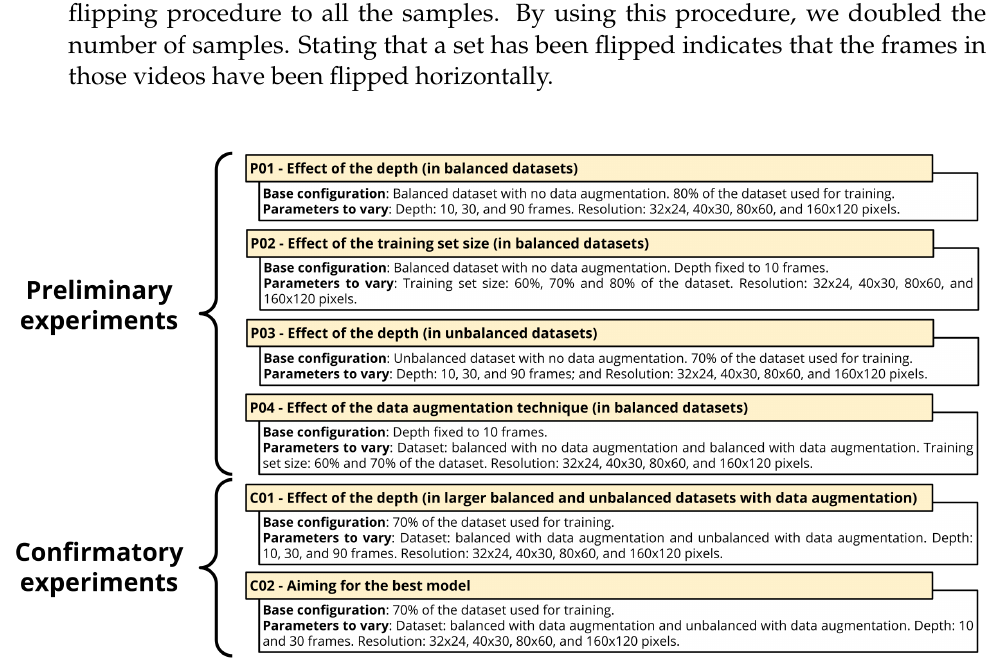
Figure 5. Overview of the experimental setup followed in this work. For a detailed description of the parameters and the relation of the samples considered for each experiment, please consult Appendix